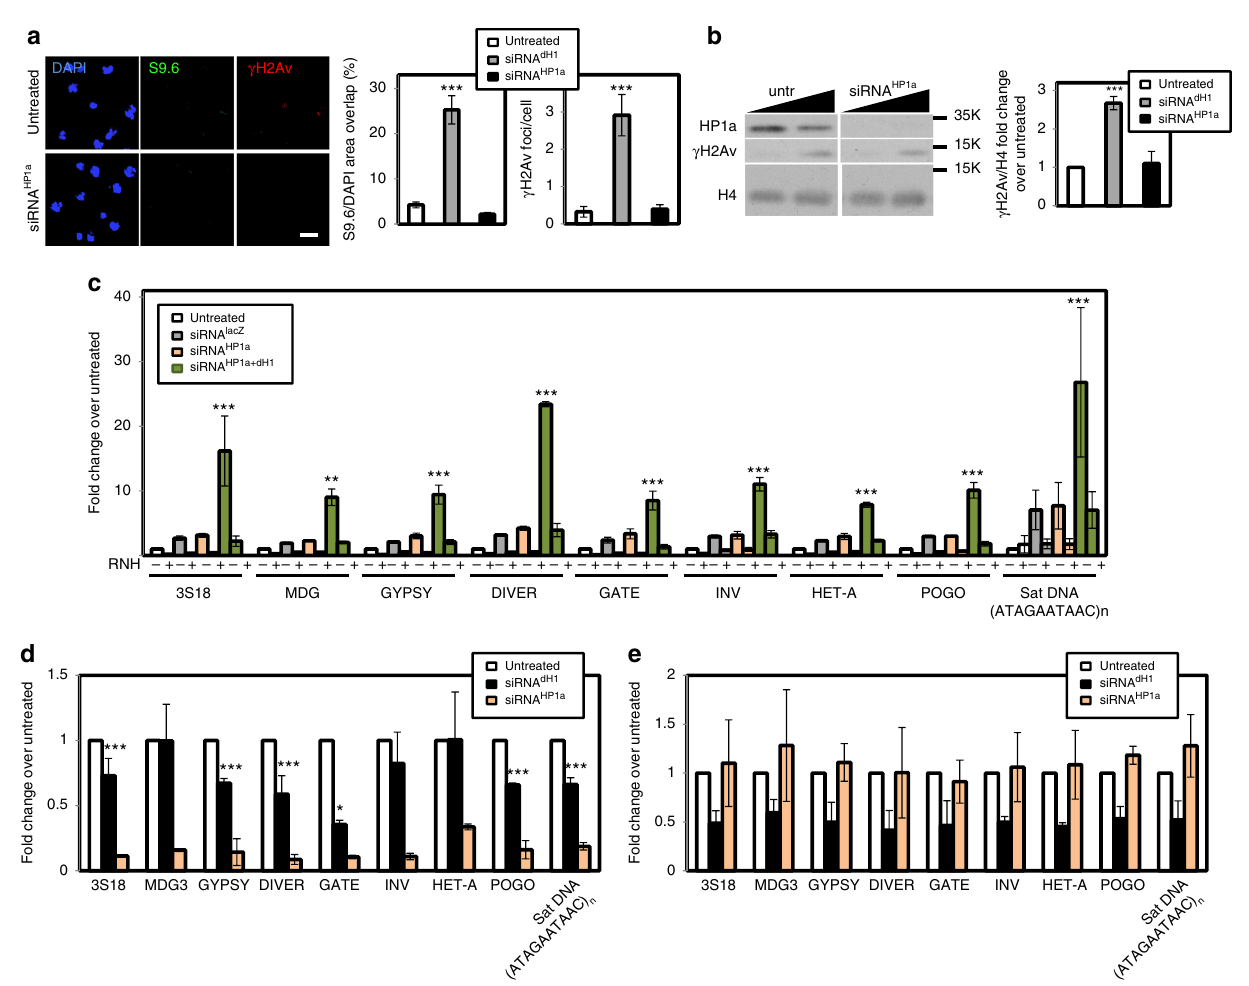
Fig. 7 HP1a depletion does not induce R-loops accumulation. a Immunostainings with αγ H2Av ( red ) and S9.6 ( green ) antibodies of siRNA HP1a and control untreated cells. Scale bar corresponds to 20 μ m. On the right , S9.6 ( left ) and γ H2Av ( right ) reactivities determined as the proportion of DAPI area stained with S9.6 antibodies and the number of γ H2Av foci per cell are presented ( n > 50 for each condition). The values obtained for siRNA dH1 cells are included for comparison. Error bars are s.e.m. The p -values of siRNA dH1 and siRNA HP1a respect to untreated are indicated (no asterisk > 0.05, *** < 0.005; two-tailed Student ’ s t -test). b WB analyses with α HP1a, αγ H2Av and α H4 antibodies of increasing amounts of extracts (lanes 1 – 2) prepared from siRNA HP1a and untreated cells. The positions corresponding to molecular weight markers are indicated. On the right , quantitative analysis of the results ( N = 2). The values obtained for siRNA dH1 cells are included for comparison. Error bars are s.e.m. The p -values of siRNA dH1 and siRNA HP1a respect to untreated are indicated (no asterisk > 0.05, *** < 0.005; two-tailed Student ’ s t -test). c DRIP-qPCR analyses at the indicated repetitive elements in siRNA HP1a , siRNA HP1a+dH1 , siRNA lacZ and untreated cells. Before immunoprecipitation samples were treated with bacterial RNH (+) or not ( − ) ( N = 2). For each repetitive element, the fold-change respect to the untreated condition at this repetitive element is presented. Error bars are s.e.m. The p -values of siRNA HP1a and siRNA HP1a+dH1 respect to siRNA lacZ are indicated (no asterisk > 0.05, ** < 0.01, *** < 0.005; two-tailed Student ’ s t -test). d HP1a ChIP-qPCR analysis at the indicated repetitive elements in siRNA HP1a , siRNA dH1 and untreated cells. For each repetitive element, the fold-change respect to the untreated condition at